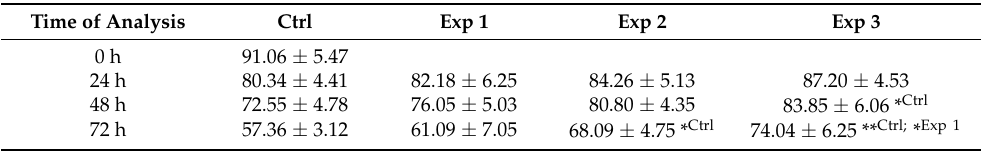
Table 4. Acrosome integrity of boar spermatozoa (%) exposed to selected semen extenders during different time